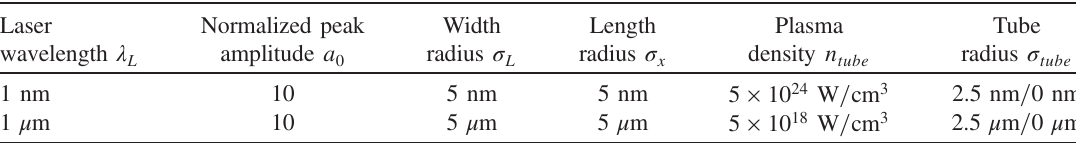
TABLE II. Summary of the laser and plasma parameters for the electron acceleration